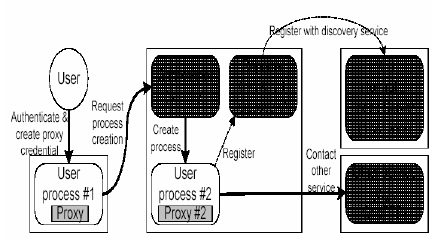
Figure 9: Selected Globus Toolkit mechanisms